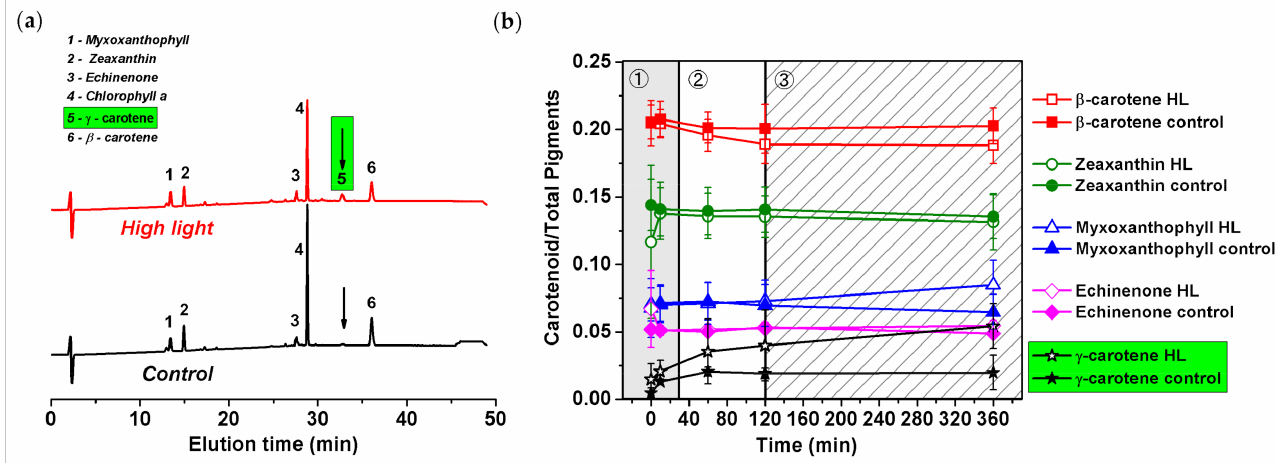
Figure 7. HPLC chromatogram and kinetic changes in carotenoid composition in Synechocystis PSI - YFP in HL and control culture. ( a ) HPLC chromatograms of the control and HL treated samples for 360 min. Position of the peaks was identified based on literature (see description). The peak presented only in HL cell (no. 5, see arrows, green bar), was identified by comparison of its retention time and absorbance with the analytical standard as G -carotene (see Figure S8). ( b ) Kinetics of carotenoid accumulation during HL treatment: control sample—closed symbols; and HL—open symbols. Data represent averages and SD obtained from three biological replicates. The three phases of cyanobacterial cell response to HL (see Konert et al. (2019) [5]) are marked by different background colors and numbers (grey—fast response; white—intermediate phase; striped—acclimation